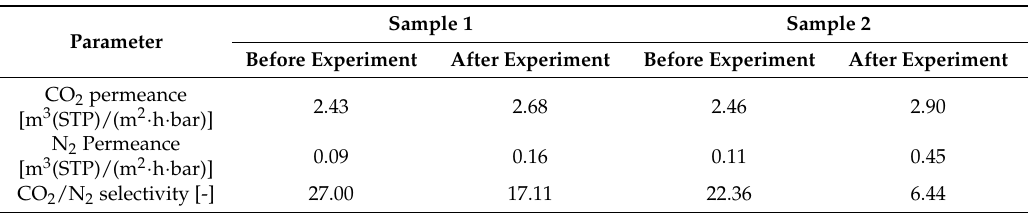
Table 6. Single gas measurements of M1c15 sample 1 and sample 2 performed before and after the experiment in the flue gas ( ϑ = 35 °C, ∆ p = 3 bar).